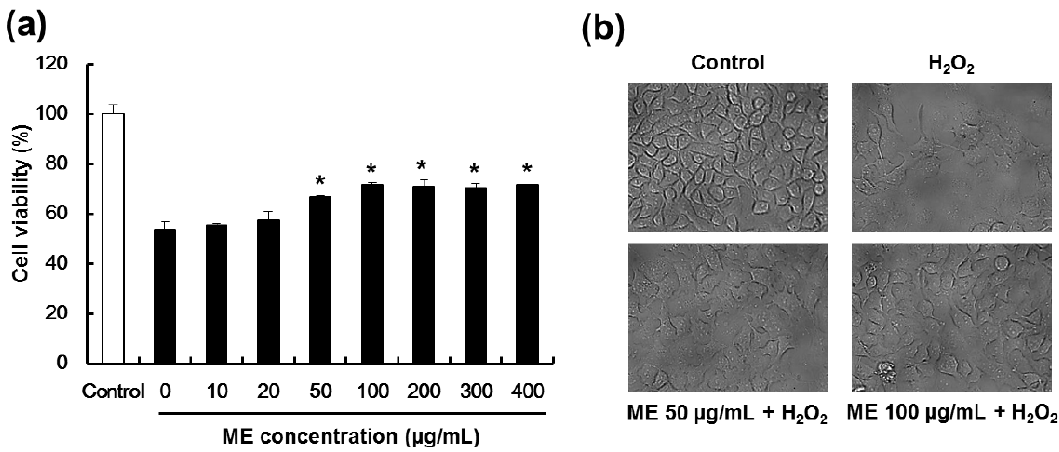
Figure 3. Protective effect of ME on hydrogen peroxide-treated pancreatic MIN6N β -cells. ( a ) Cell viability of pancreatic MIN6N β -cells treated with various concentrations of ME followed 0.7 mM hydrogen peroxide treatment. Data represent the mean ± SE of three independent experiments. Significance of the differences were compared with the hydrogen peroxide-treated group at * p < 0.05 by Student’s t -test. ( b ) Morphological characteristics of pancreatic MIN6N β -cells after various treatments. Morphology of MIN6N cells was observed by optical microscopy. Control, 0.7 mM hydrogen peroxide for 4 h, 0.7 mM hydrogen peroxide for 4 h with 50, and 100 μ g/mL of ME, respectively. Magnification: